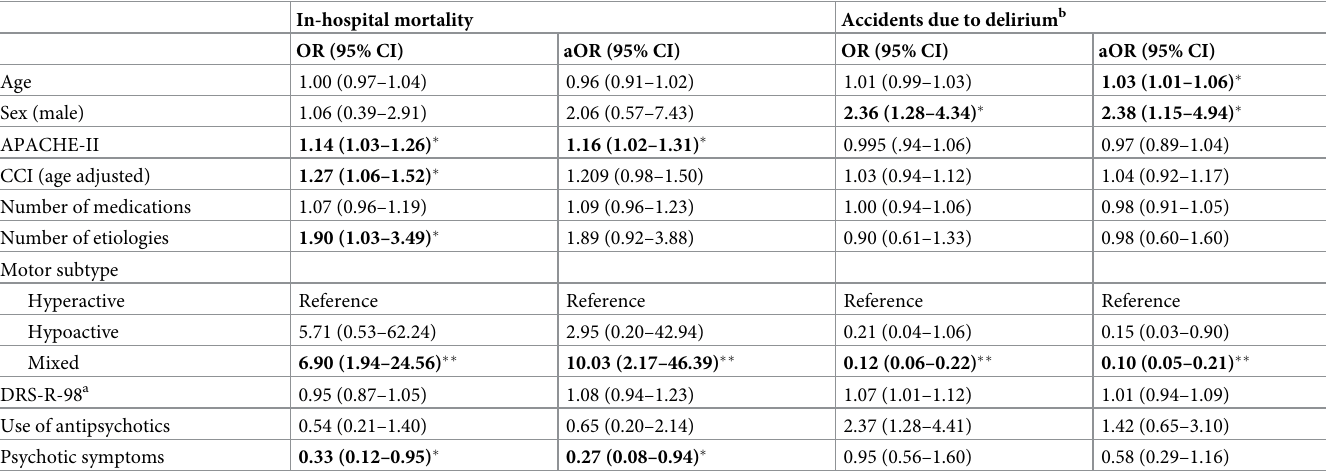
Table 3. Logistic regression analysis for in-hospital mortality and